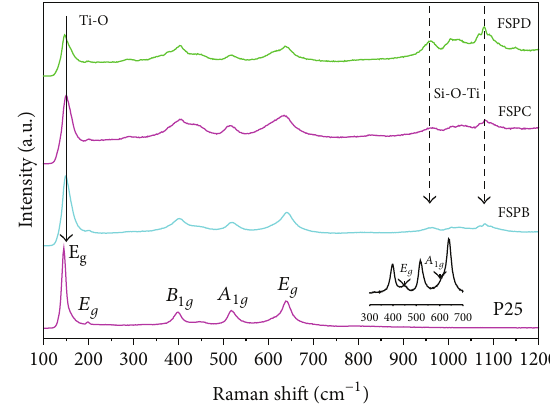
Figure 3: Raman spectra of samples P25, FSPB, FSPC, and FSPD.